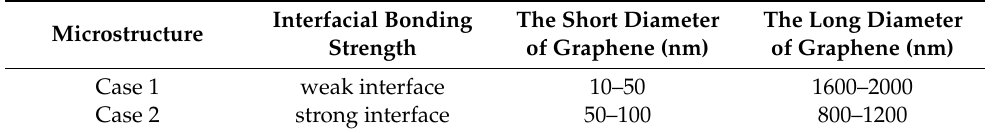
Table 5. Microstructure types of AG composites.